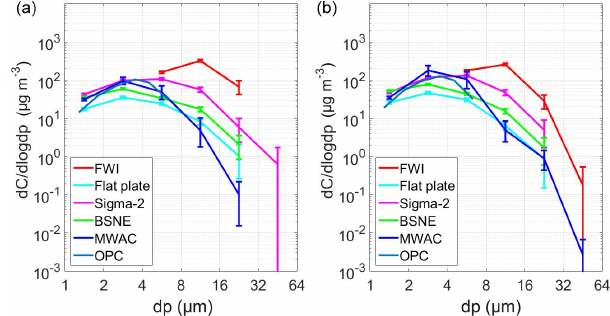
Figure 12. Daily average mass size distributions obtained from the passive sampler techniques in comparison to an active sampler (FWI). Mass concentration size distributions were calculated from the SEM mass flux measurements using the corresponding depo- sition velocity models. Samples were collected on 26 July (a) and 27 July (b) . The mass concentration measurements shown by the FWI are daily averages (three samples per day). The bars show the central 95% confidence interval of the daily